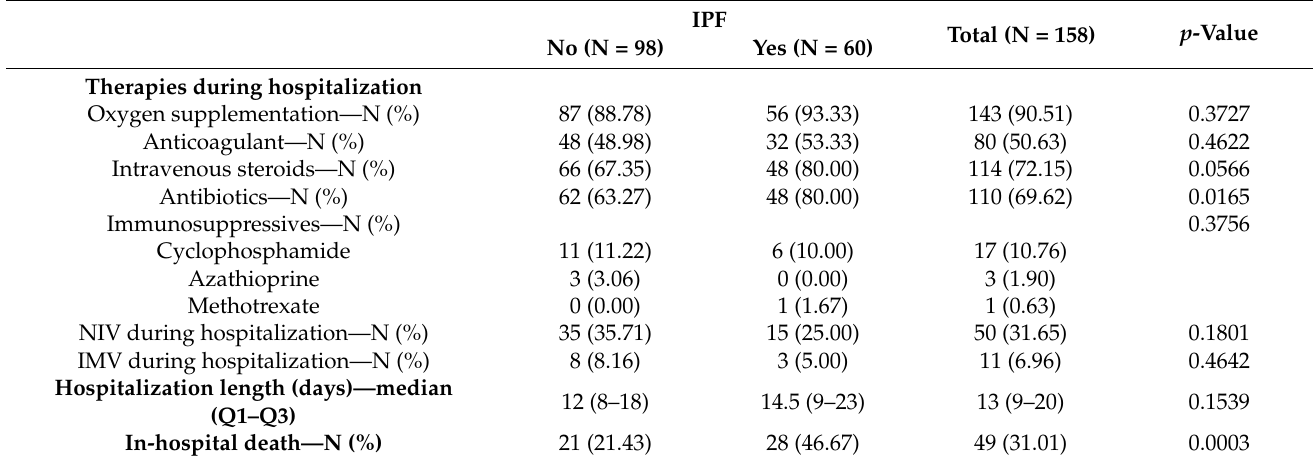
Table 3. Therapy during the hospitalization for AE and